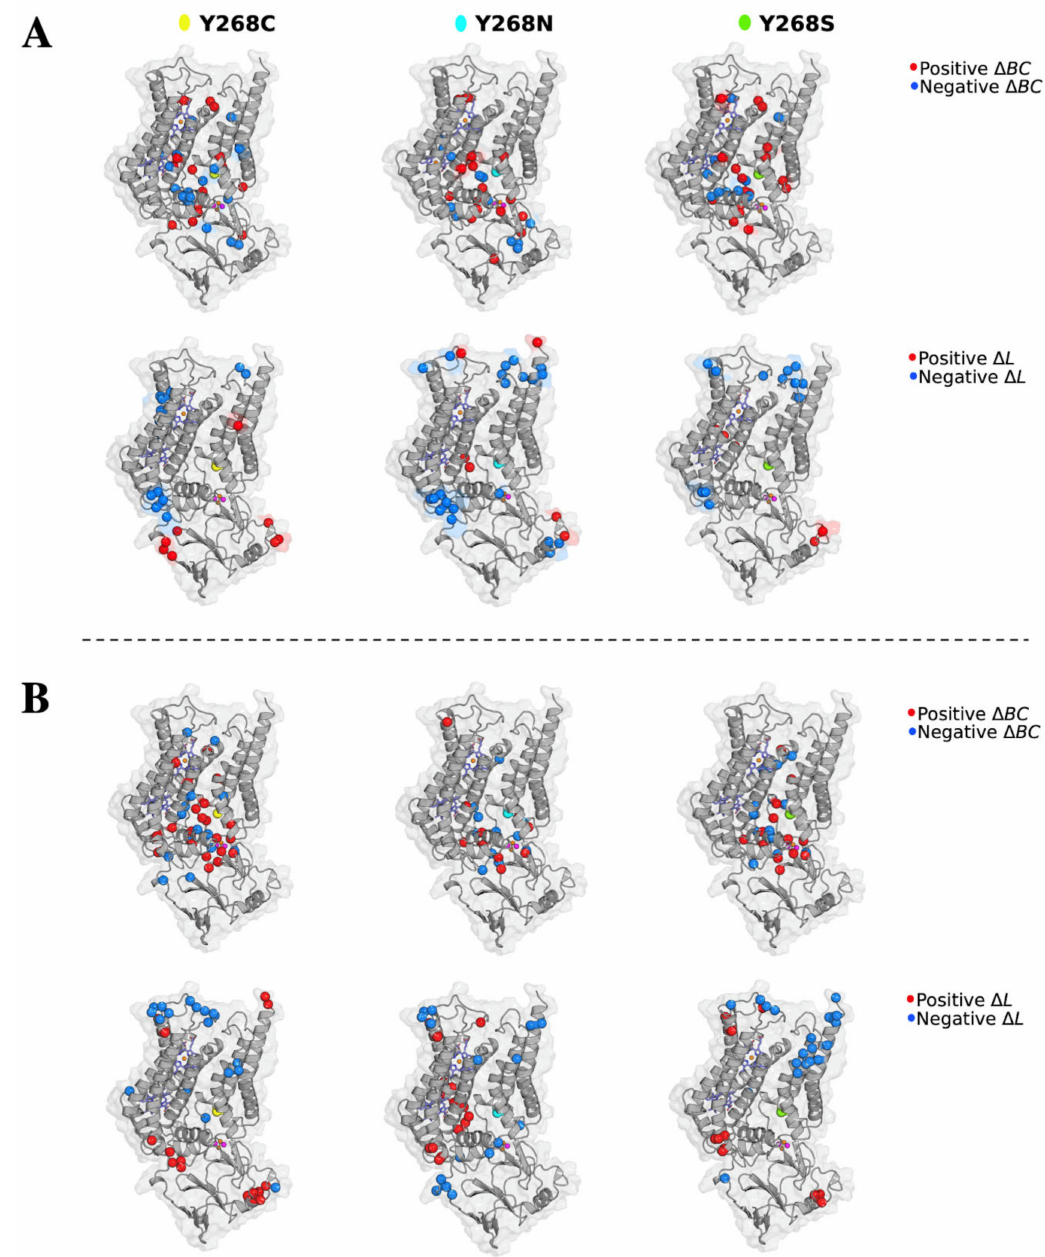
Figure 10. Effect of the three mutations Y268C, Y268N and Y268S on the protein intra-communication in the holo protein. ( A ) PfCytb-ISP holo protein ( B ) PfCytb-ISP ATQ-bound protein. Residues exhibiting a significant change in average betweenness centrality ( ∆ BC ) are mapped onto the structure. The change in ∆ BC was calculated as WT (wild-type) — mutant. The red spheres therefore represent residues with positive ∆ BC values, i.e., residues that lost centrality in the mutant model relative to the WT. The blue spheres represent residues with negative ∆ BC values, i.e., residues that gained more centrality in the mutant models relative to the WT ( B ) Residues exhibiting a significant change in average accessibility ( ∆ L ) are mapped onto the structure. Change in ∆ L was calculated as WT — mutant. The red spheres therefore represent residues with positive ∆ L , i.e., residues that increased accessibility in the mutant model relative to the WT. The blue spheres represent residues with negative ∆ L values, i.e., residues that decreased accessibility in the mutant model relative to the WT. Concerning residue accessibility, the DRN which represents the protein in the form of nodes (residues) with their connections (edges) was analyzed. Here, the residues